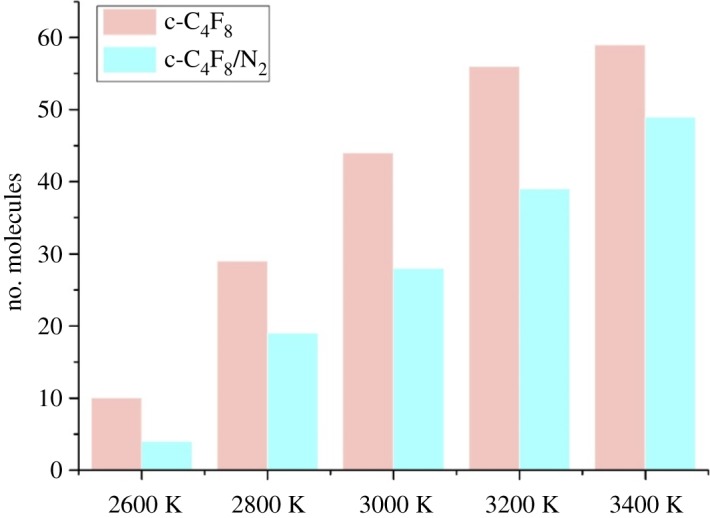
Maximum number of decomposed c-C4F8 at 2600–3400 K.